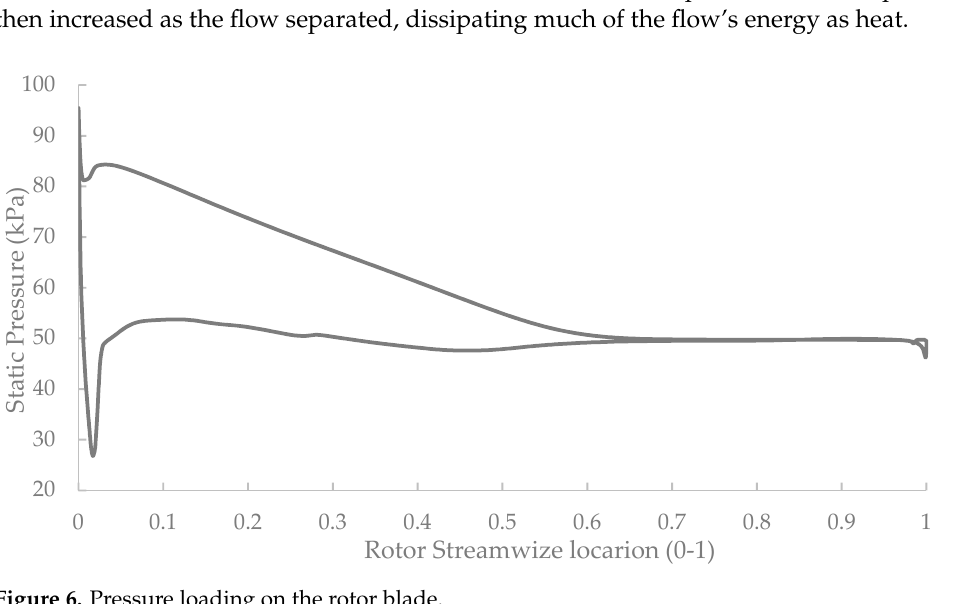
Figure 6. Pressure loading on the rotor blade.